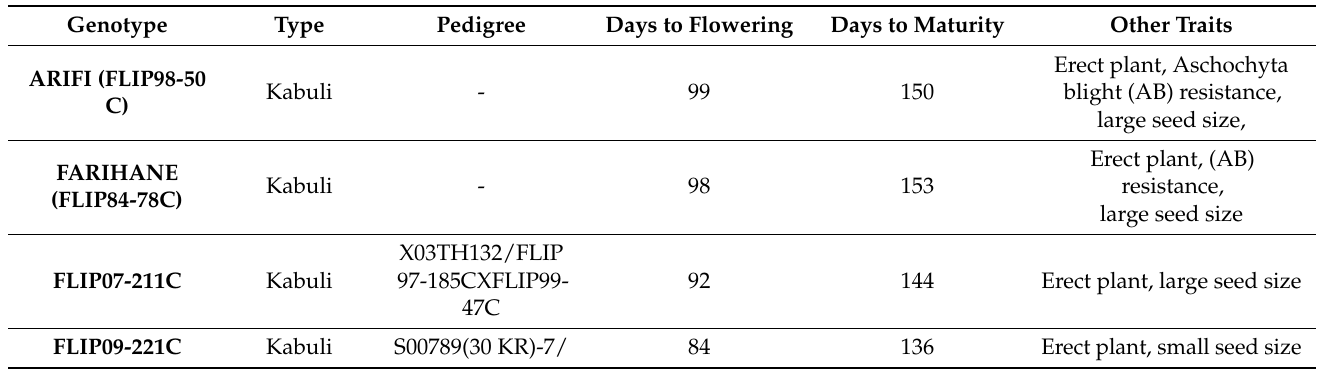
Table 1. Characteristics of the studied chickpea